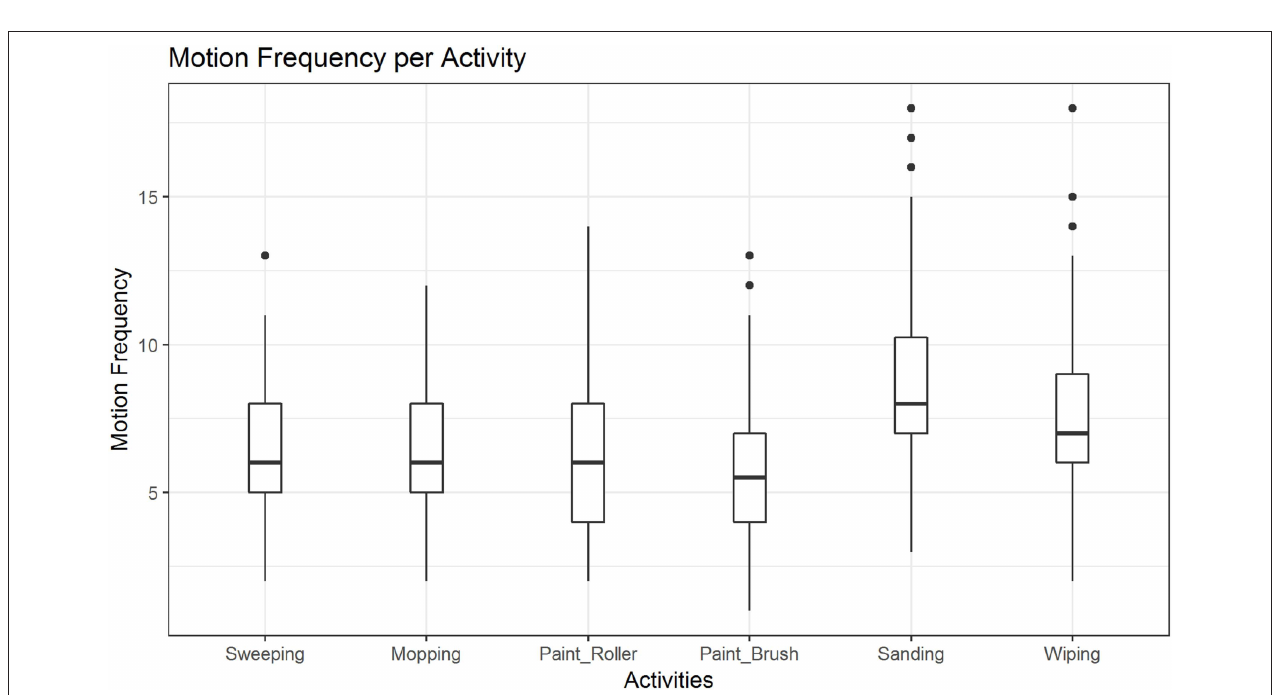
FIGURE 7 | Distribution of motion frequency across activities. A significant difference is found between the mean motion frequency of sanding vs. wiping ( p < 0.01).